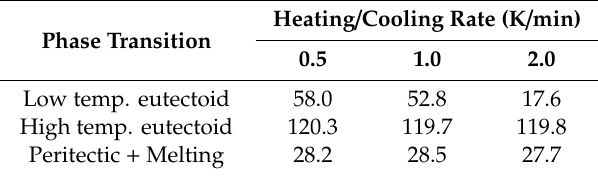
Table 6. Enthalpy of phase transition (J / g) associated to the endothermic phenomena appearing in the DSC thermograms in Figure 10.